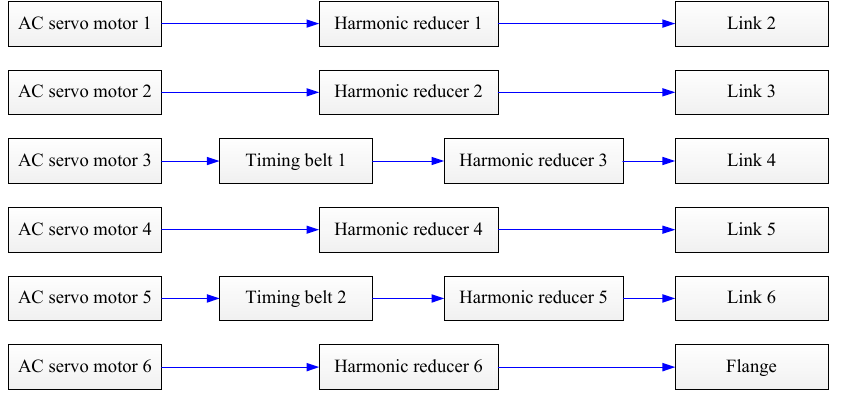
Figure 3. The joint transmission chains of the robot.